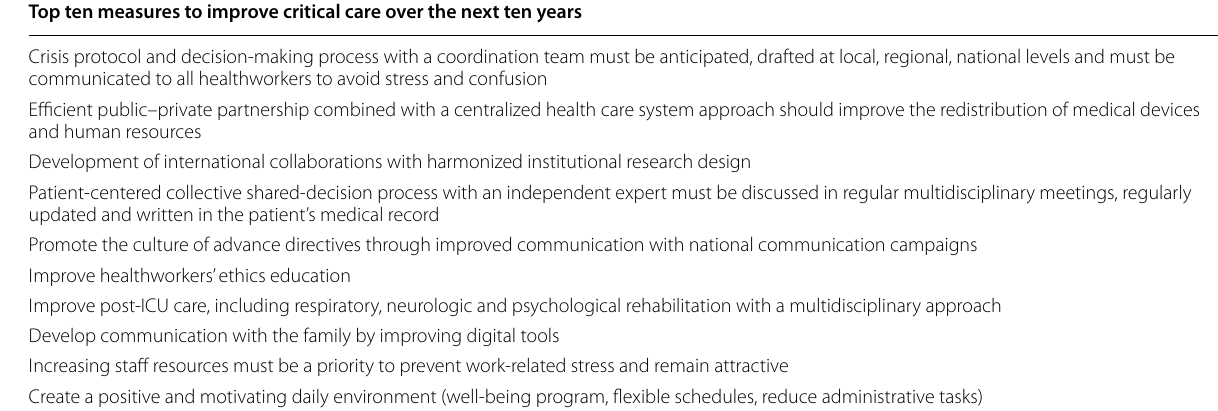
Table 3 Top ten measures to improve critical care 449 over the next 10 years 450 Top ten measures to improve critical care over the next ten years Crisis protocol and decision-making process with a coordination team must be anticipated, drafted at local, regional, national levels and must be communicated to all healthworkers to avoid stress and